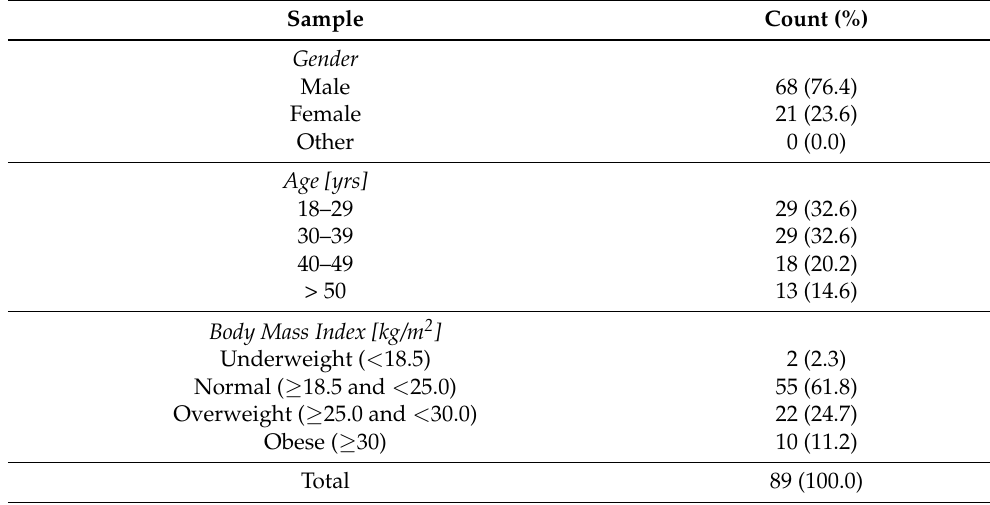
Table 2. Demographic summary of